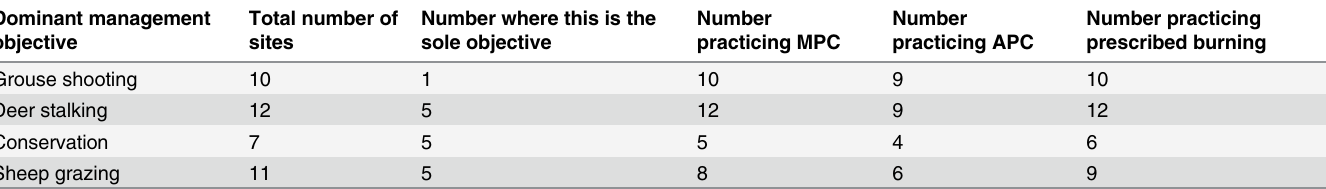
Table 1. Summary of management objectives and activities associated with each estate. Dominant management